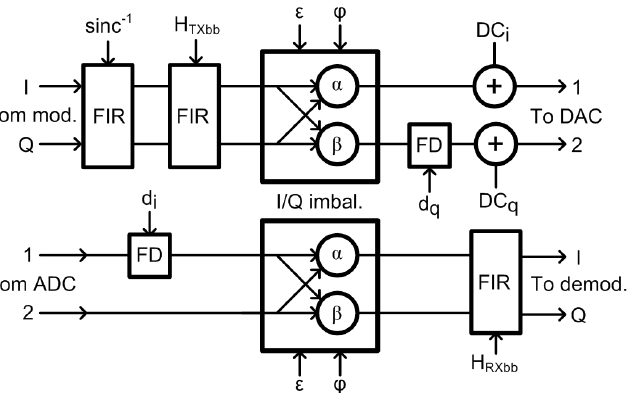
Figure 4. Digital baseband compensation blocks. (FIR: Finite Impulse Response. FD: Fractional De-